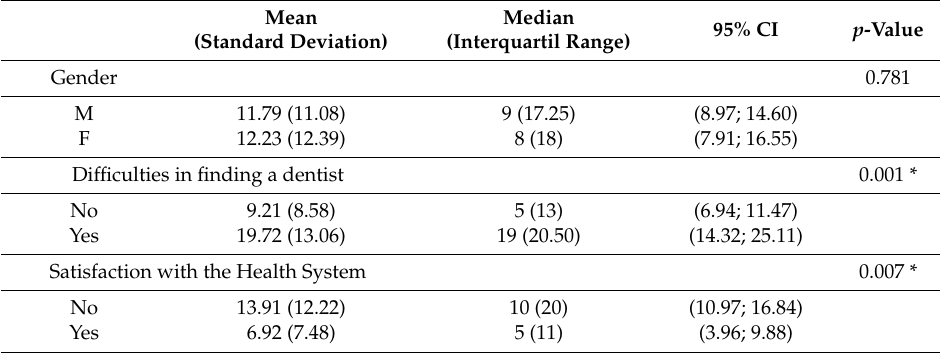
Table 1. Descriptive statistics from OHIP (Oral Health Impact Profile)